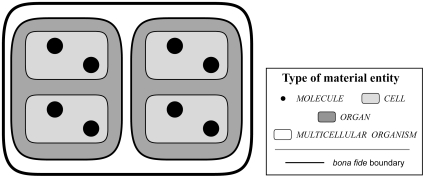
Constitutive Granularity.A constitutive granularity of molecules, cells and organs of a multicellular organism. It is characteristic of constitutive granularities that all objects belonging to one level of granularity are parts of objects of the next coarser level of granularity: all molecules are part of cells, all cells part of organs, and all organs part of multicellular organisms. Moreover, the sum of all objects of one level of a constitutive granularity yields the maximal object, which is in this case a multicellular organism.